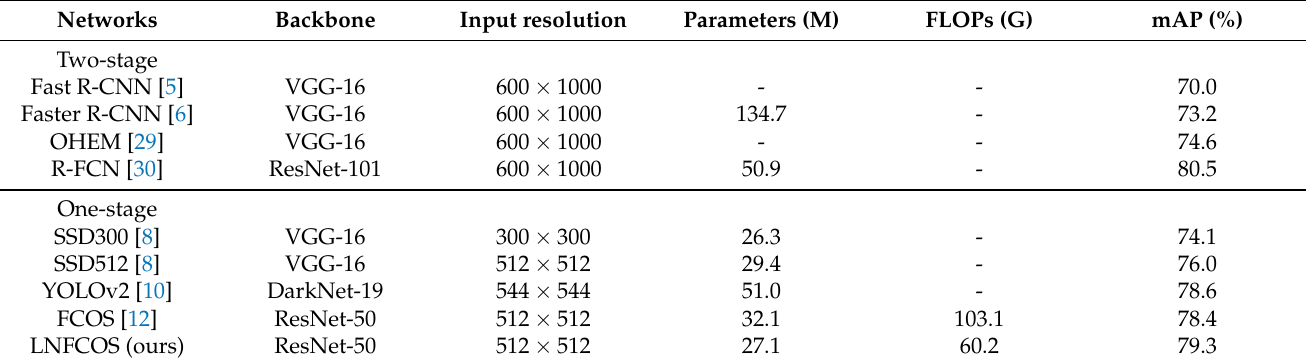
Table 2. Comparison of other networks with PASCALVOC 07 test dataset.